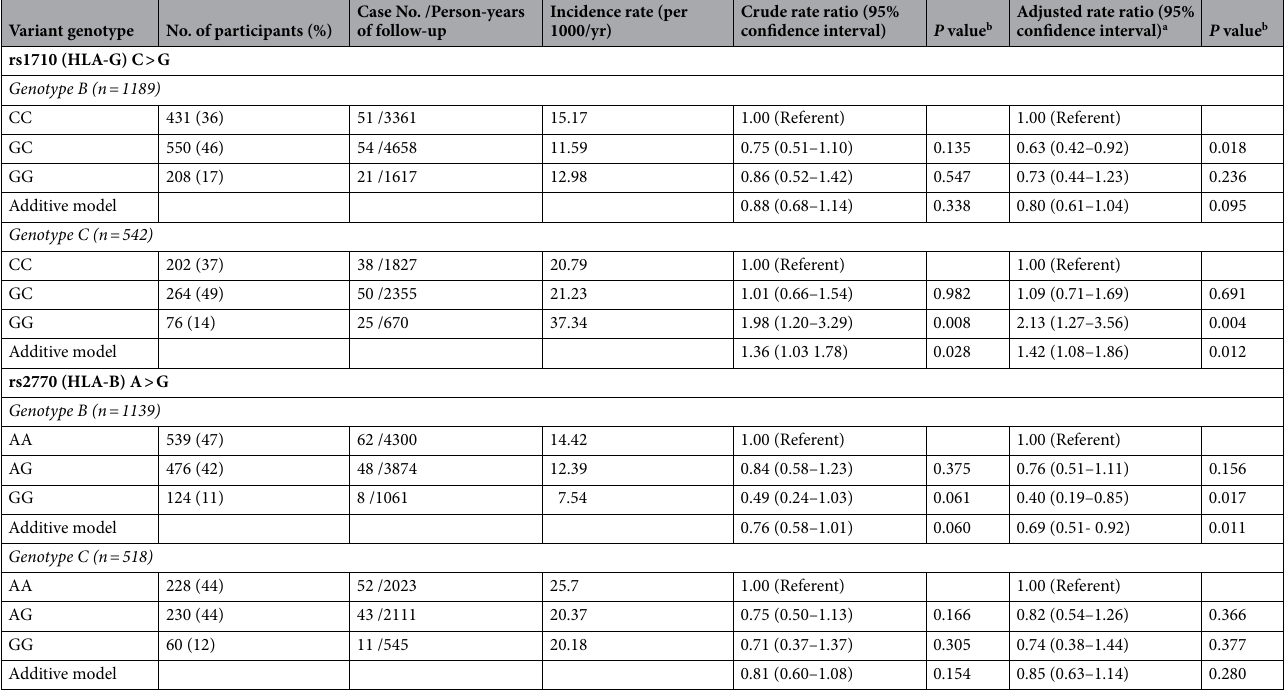
Table 2. Incidence rate and multivariate-adjusted rate ratio of HBsAg seroclearance by HLA variants and HBV genotypes. a Adjusted for age, gender, body mass index, and levels of HBV DNA and HBsAg. b Estimated by Cox proportional hazards model. # P value for interaction between HBV genotype and rs1710 is 0.0044 (additive model). P value for interaction between HBV genotype and rs2770 is 0.3588 (additive